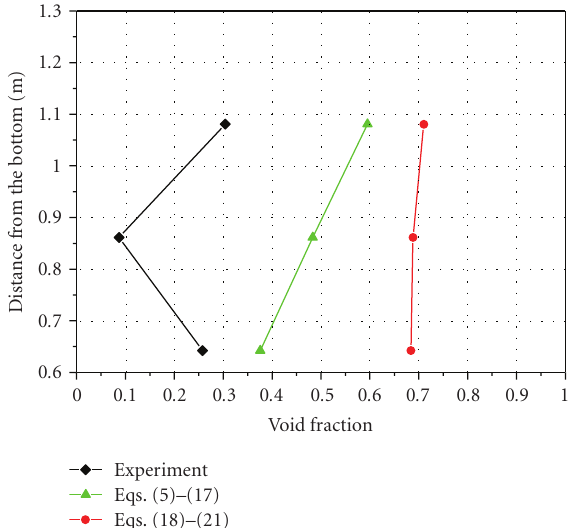
Figure 6: Void fraction profile along height of the left downcomer in the experiment and in the calculations with the use of the models (5)–(17) and (18)–(21).